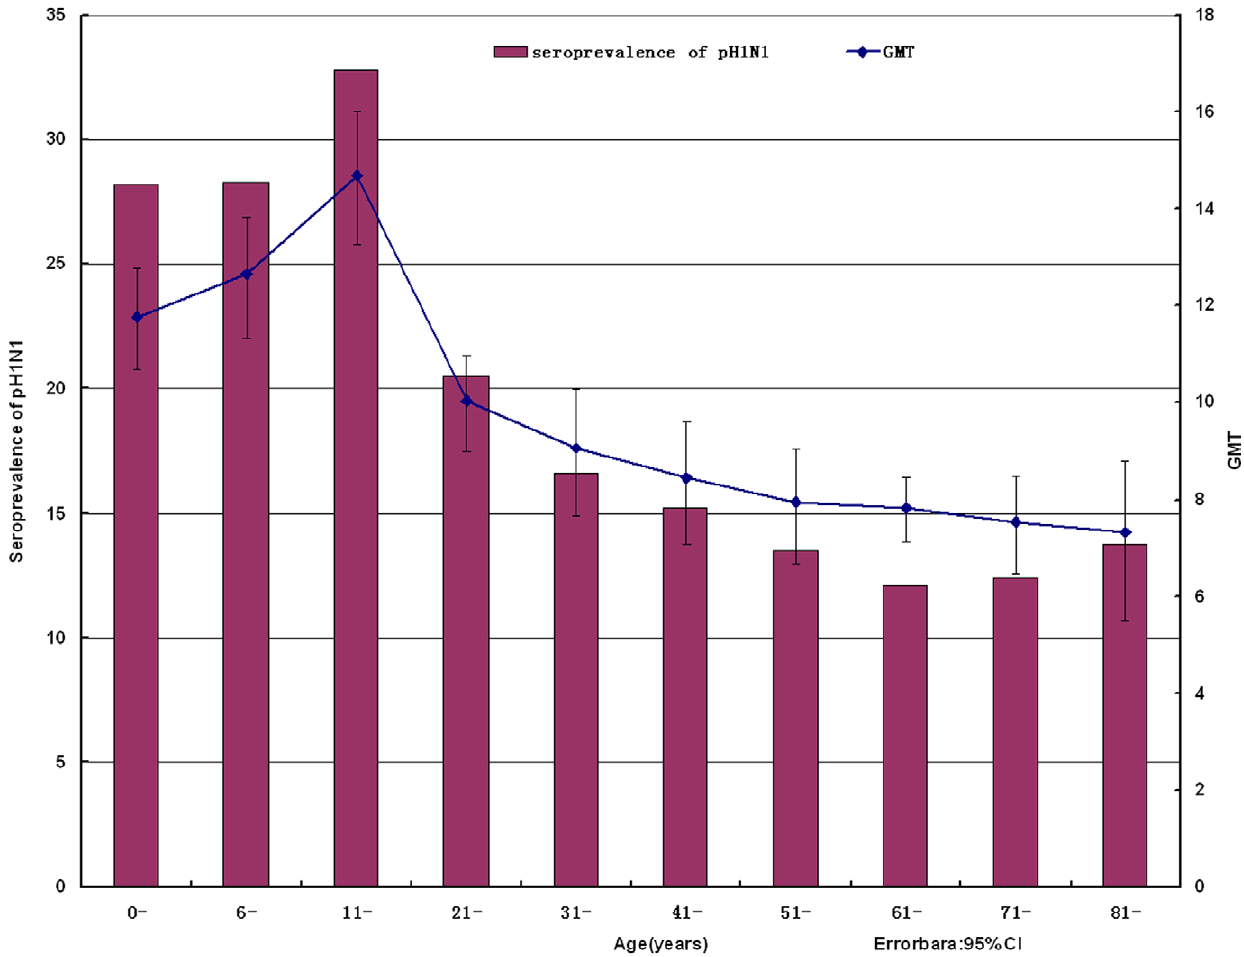
Figure 1. Antibody titers to A/California/7/2009 by HI (hemagglutination inhibition assay). The geometric mean titers (GMTs) and the seroprevalences were plotted according to the age distribution. The 95% confidence intervals (95%CI) for individual HI GMTs were shown as error bars.